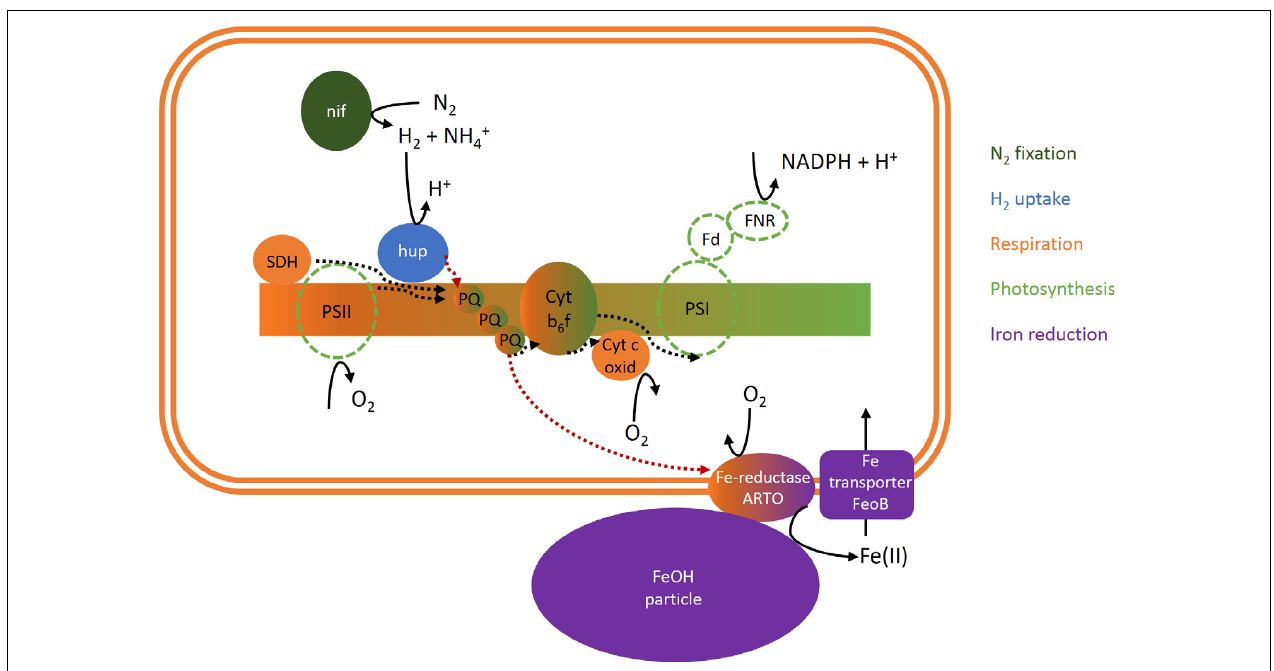
FIGURE 7 | Scheme of a potential cellular link between N 2 fixation, H 2 and O 2 fluxes and iron uptake in Trichodesmium. Dotted lines indicate electron flow. Please note that uptake hydrogenase may be restricted to non-photosynthetic diazocytes and/or located on the cytoplasmic membrane instead of the thylakoid membrane and thus coupled to respiratory electron transport but not photosynthesis (Tamagnini et al., 2002; Khanna et al., 2016). ARTO, alternative respiratory terminal oxidase; Cyt b 6 f, cytochrome b 6 f complex; Cyt c oxid, cytochrome c oxidase; Fd, ferredoxin; FeoB, ferrous iron transporter B; FeOH, iron oxide; FNR, ferredoxin-NADPH-oxidoreductase; hup, uptake hydrogenase; nif, nitrogenase; PQ, plastoquinone; PSI, photosystem I; PSII, photosystem II; SDH, succinate